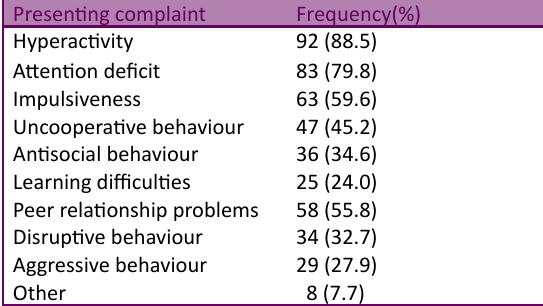
Table 2 – Frequency distribution of the presenting complaints reported by parents